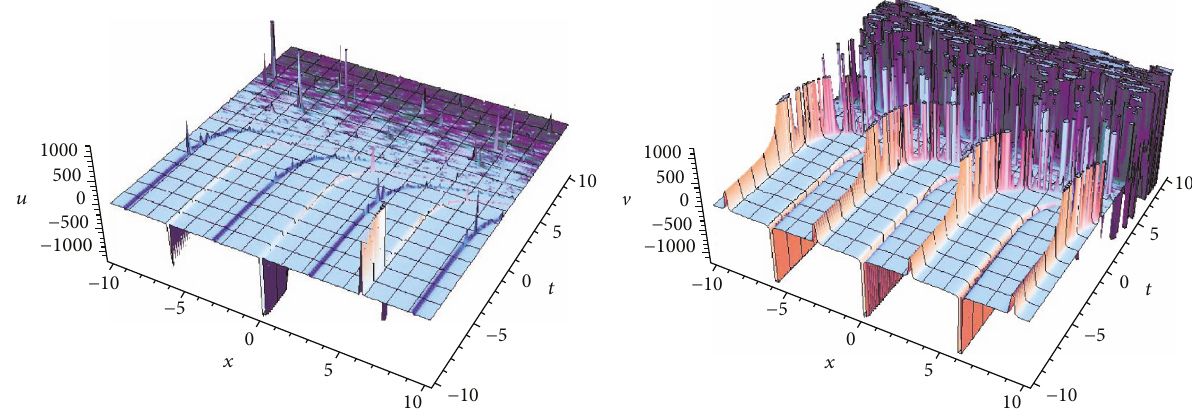
Figure 7: Spatial structures of solutions (33) determined by (52) given m = 1